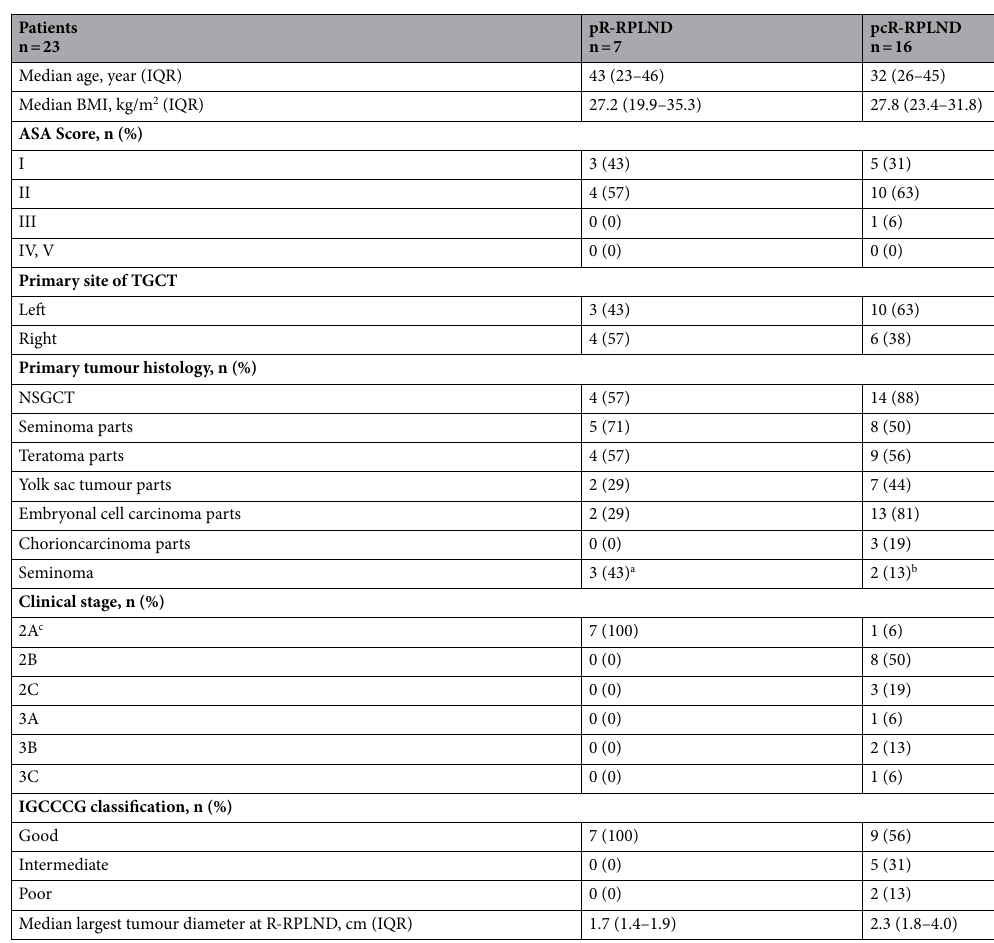
Table 1. Baseline characteristics of patients prior to R-RPLND. yr years, IQR interquartile range, BMI body mass index, ASA American Society of Anaesthesiologists, TGCT testicular germ cell tumour,